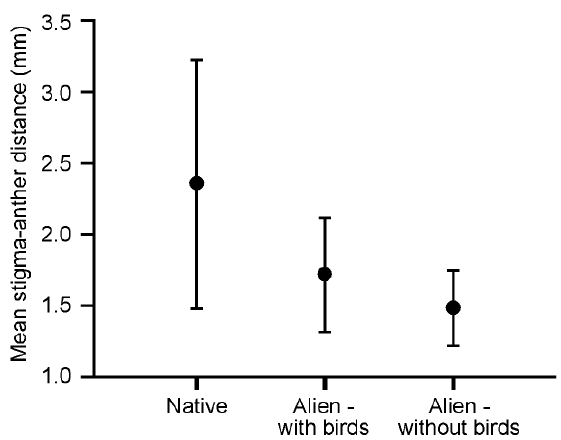
F IGURE 3: Mean (± 95% confidence interval) stigma-anther distance for native populations of Nicotiana glauca (“Native” – n = 7 populations) compared to non-native populations within (“Alien-with birds” – n = 11 populations) and outside (“Alien- without birds” – n = 6 populations) of the range of specialised flower visiting birds (hummingbirds and sunbirds). One-way ANOVA: F 2,20 = 4.4, P = 0.027. Only the contrasts between Native vs. Alien-with birds (LSD post-hoc test: P = 0.03) and Native vs. Alien-without birds (LSD post-hoc test: P = 0.01) are significantly different, but there is an apparent trend and the latter has only a small sample